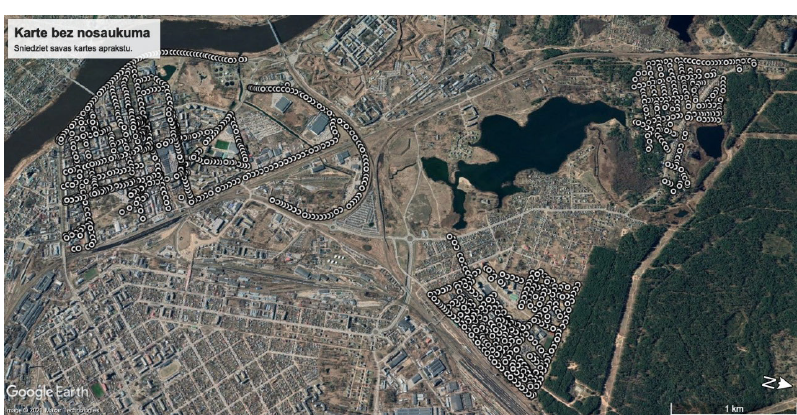
b) GPS coordinates of measurement points of large Figure 13. Large-scale street profile measurement plan (a) and GPS coordinates of the taken measurements